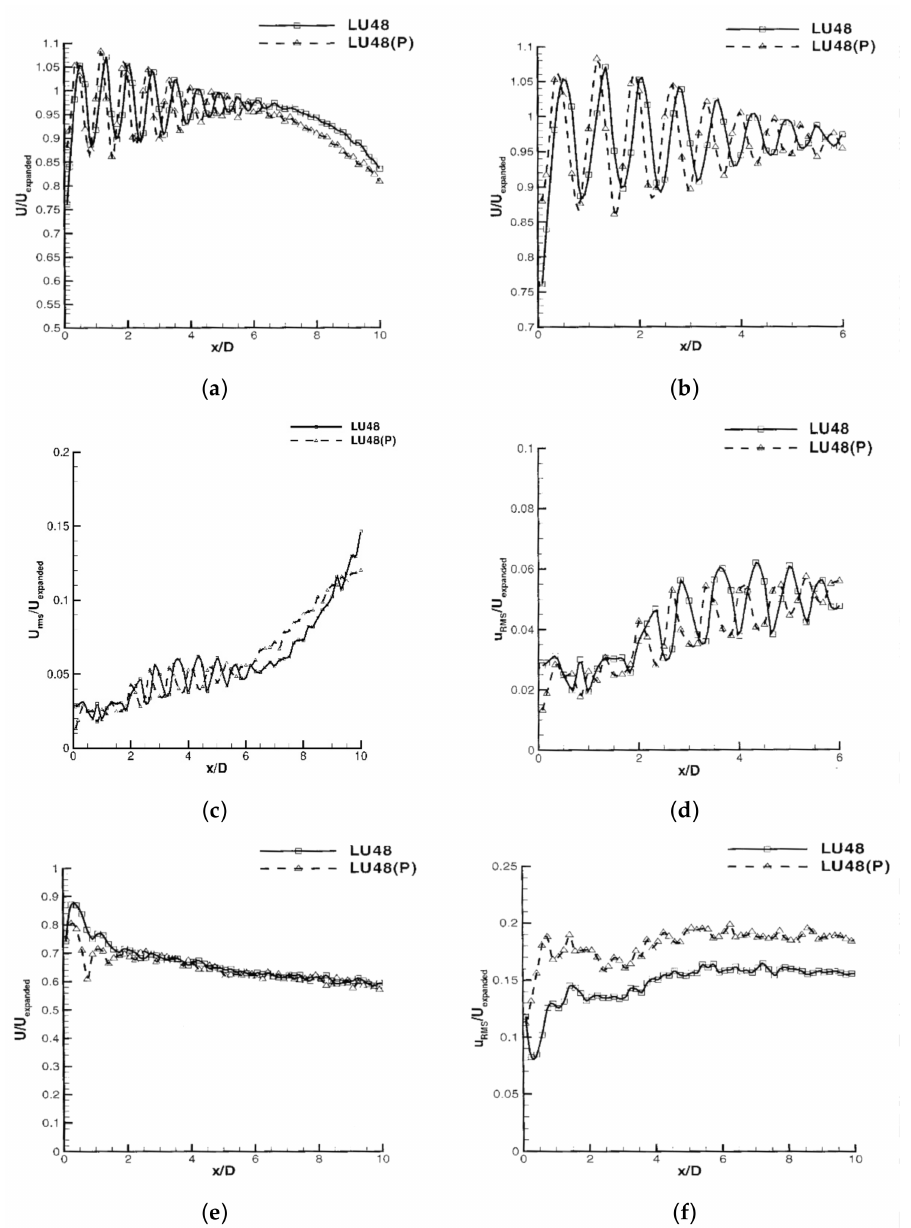
Figure 19. LU48/LU48P centreline and lipline profiles—NPR = 2.40. Top: centreline—( a ) axial velocity; ( b ) axial velocity (detail); Middle: centreline—( c ) axial rms turbulence; ( d ) axial rms turbulence (detail). Bottom: lipline—( e ) axial velocity; ( f ) axial rms